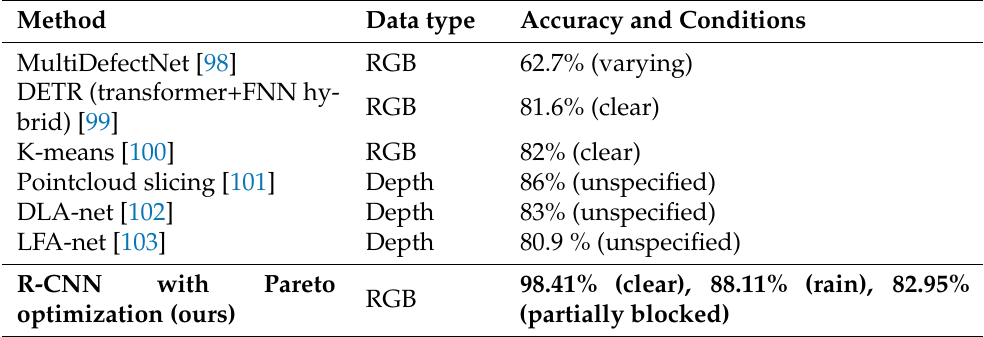
Table 2. Comparison of classification accuracy with other